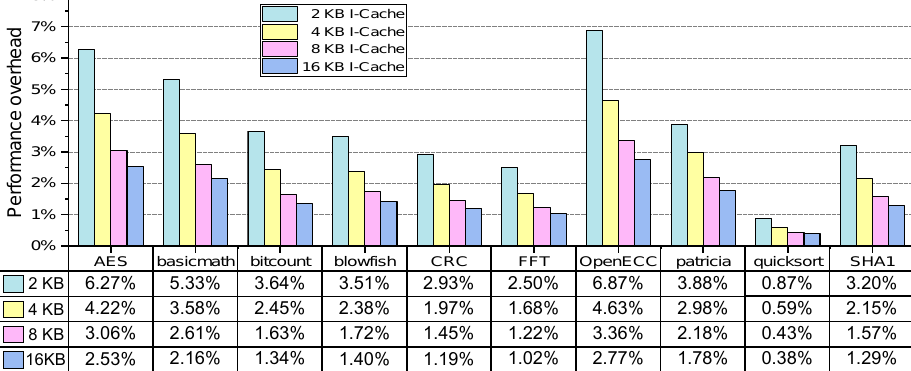
Figure 12. Performance overheads of ten selected benchmarks under the different sizes of